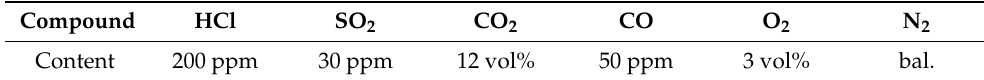
Table 2. Testing atmosphere